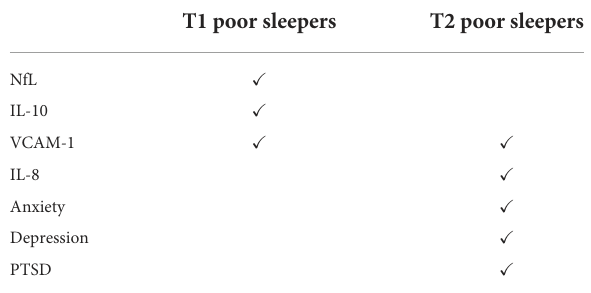
TABLE 7 Summary of main clinical-laboratory patterns in poor sleepers at T1 and T2 study visits. T1 poor sleepers T2 poor